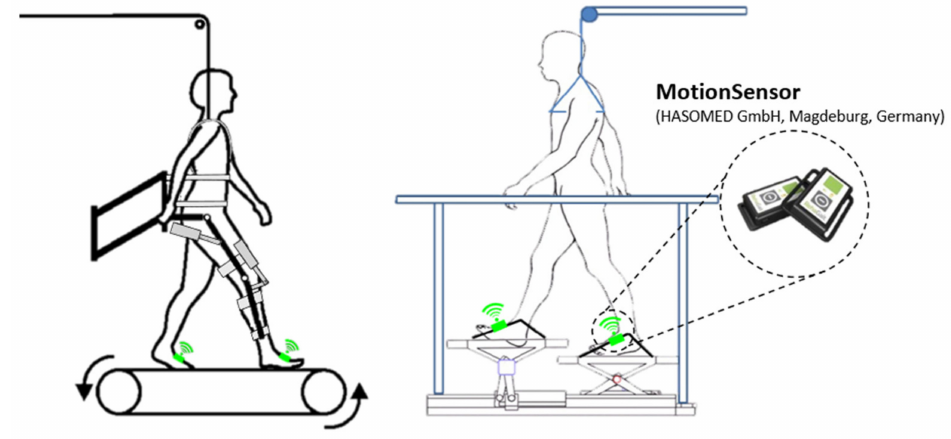
Figure 4. Experimental setup of Lokomat (left) and Lyra (right), adapted from